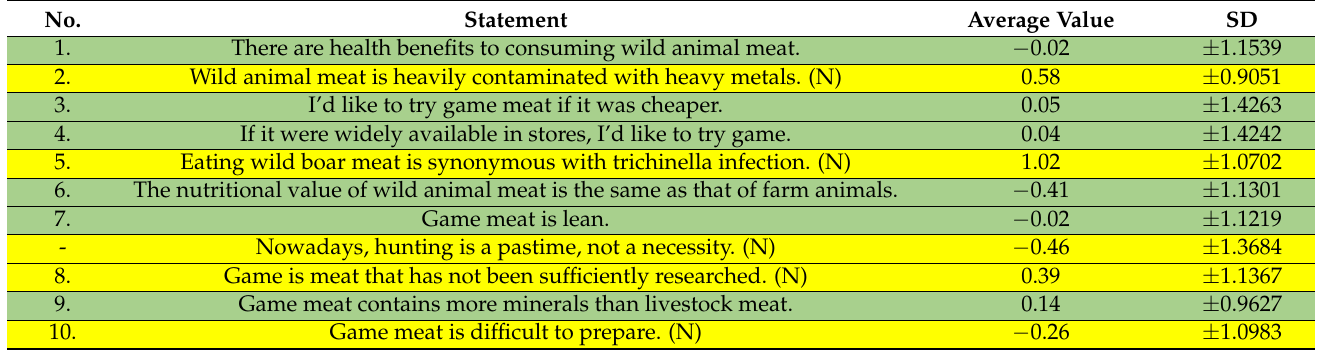
Table 1. Description statistics of the list of statements for identifying the attitudes of respondents toward game obtained in the pilot